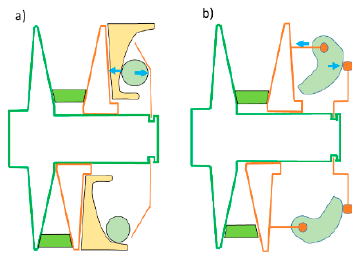
Figure 9. Centrifugal actuation system: ( a ) ramps and roller weights, ( b ) flyweight cam.